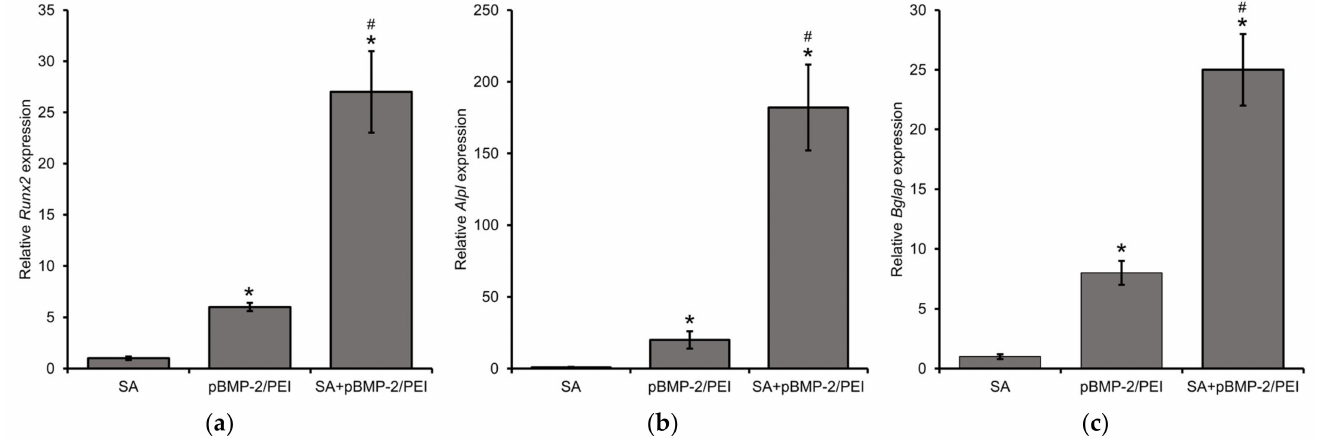
Figure 4. Relative gene expression levels of osteogenic markers: ( a ) Runx2 , ( b ) Alpl , and ( c ) Bglap after 2 weeks incubation of MSCs with gene-activated scaffolds impregnated with pBMP-2/PEI. Real-time PCR. *— p < 0.05 (vs. SA) and #— p < 0.05 (vs.